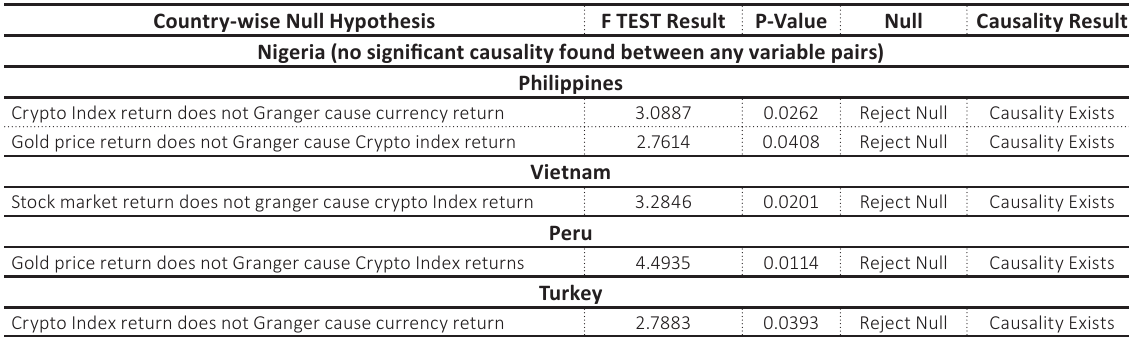
Table 2. Summary of significant causality